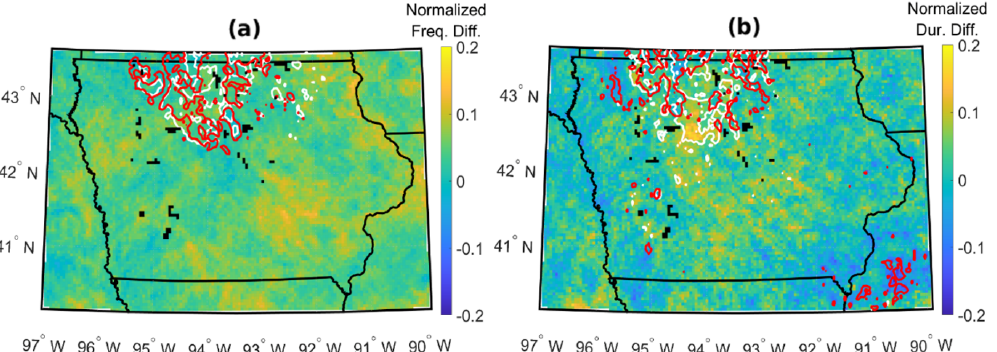
Figure 12. Mean spatial results for December 2007–May 2008, inclusive. Maps colored by difference in (a) normalized LLJ frequency and (b) normalized LLJ duration for output at full resolution and down-sampled to seven layers. Contours represent regions of highest 5% of (a) LLJ frequency and (b) LLJ duration for output at full resolution (white) and down-sampled to seven layers